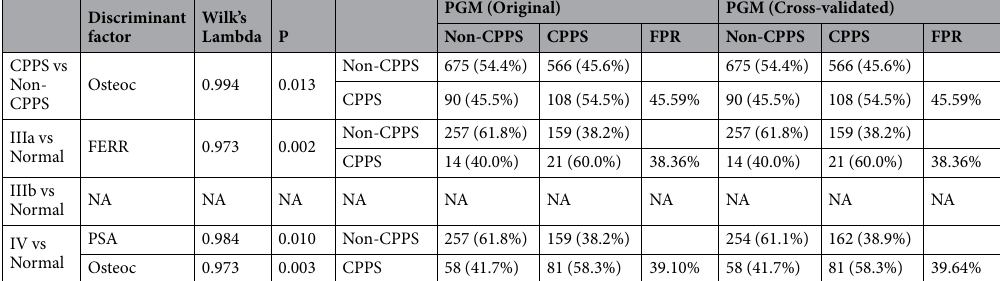
Table 4. The results of discriminant analysis for CPPS vs Non-CPPS, IIIa vs Normal, IIIb vs Normal and IV vs Normal groups. * FPR = false positive rate; PGM = Predicted Group Membership. * 22 biochemical markers in our study were included in this